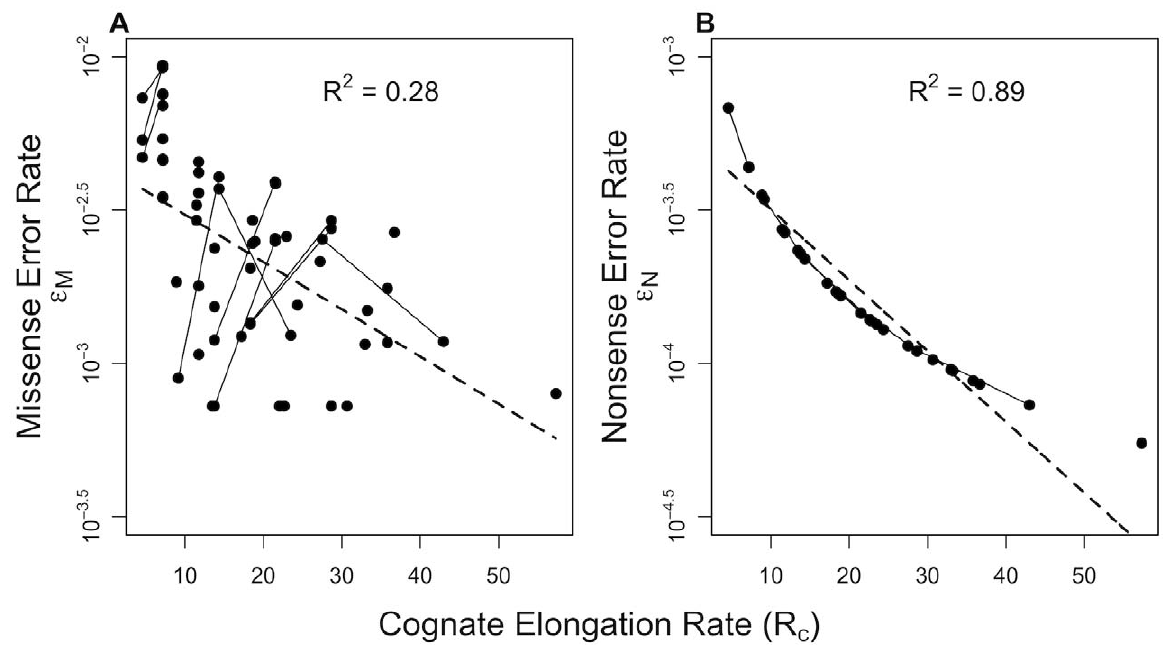
Figure 3. Correlation of translation error rates e with cognate elongation rate R c in E.coli . We find that rates of both (A) missense e M and (B) nonsense errors e N are negatively correlated with the rate of elongation by cognate tRNAs at that codon. The dashed line indicates the regression line between R c and e . This is consistent with expectations under the standard model. However, in the case of twofold degenerate amino acids ( D 2 ), whose two codons are joined together by solid lines, we see that e M increases with R c for 8 out of 10 amino acids. In the case of e N every amino acid showed a decrease in e N with R c .